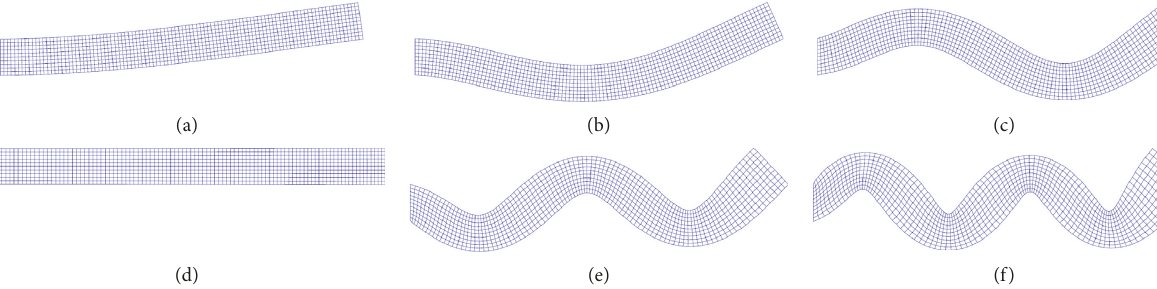
Figure 13: First 6 mode shapes of the cantilever PCMs beam by CSFEM and FEM. (a) Mode shape 1. (b) Mode shape 2. (c) Mode shape 3. (d) Mode shape 4. (e) Mode shape 5. (f) Mode shape 6.